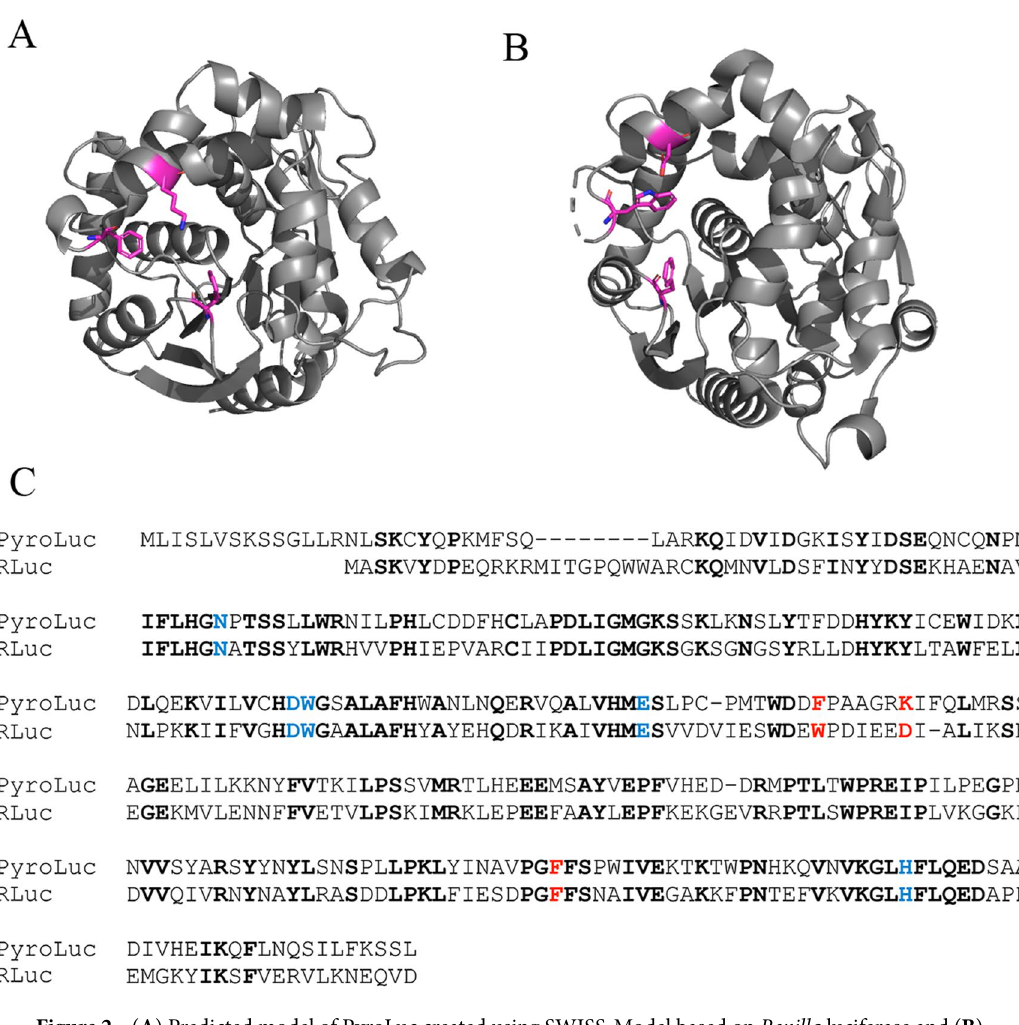
Figure 2. ( A ) Predicted model of PyroLuc created using SWISS-Model based on Renilla luciferase and ( B ) model of Renilla luciferase (2PSJ 33 ). Both models were rendered in PyMOL 2.3 (https ://pymol .org). Magenta sticks show conserved active site residues in the coelenterazine binding site. ( C ) Alignment of PyroLuc and RLuc. The residues highlighted in blue make up the catalytic triad in RLuc and those in red represent those in the coelenterazine binding site. Bold type represents identical